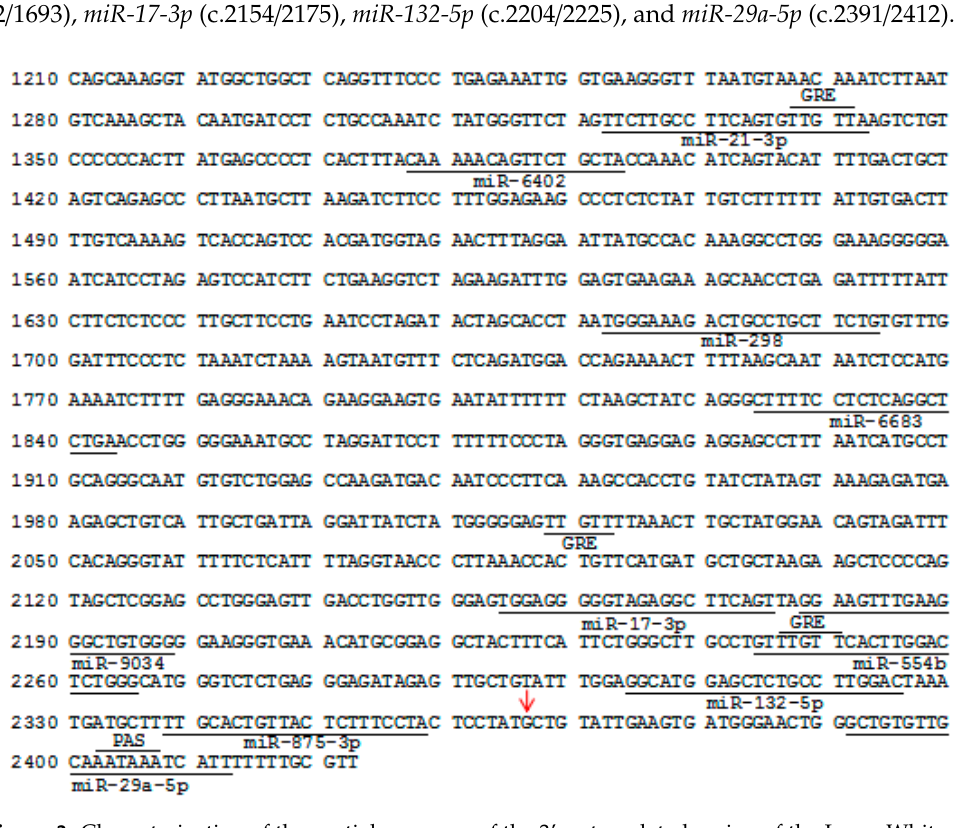
Figure 3. Characterization of the partial sequence of the 3’-untranslated region of the Large White pig BMP15 gene. The transcription start codon was assumed as +1 (GenBank ID: NM_001005155.2). The underline indicates the regulatory elements. Red arrows indicate the mutation c.2366G>A.